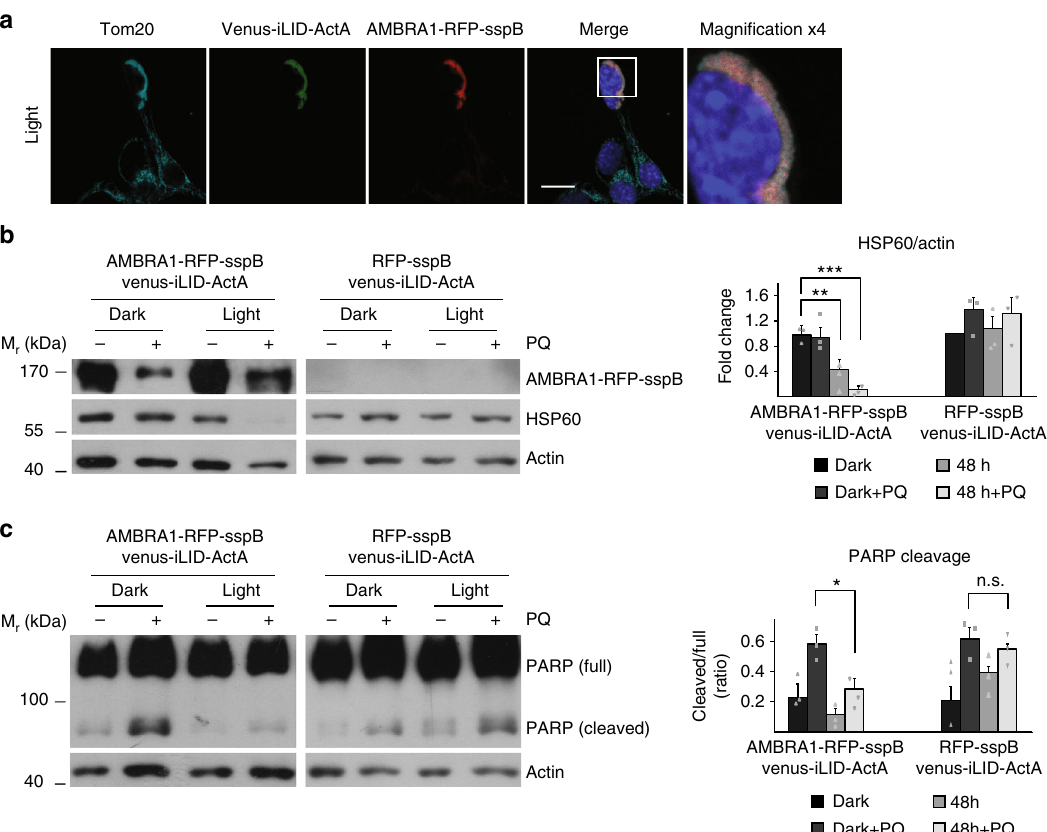
Fig. 6 Optogenetic-mediated mitophagy prevents apoptosis in a model of neurotoxicity. a ETNA (Embryonic Telencephalic NAïve) cells co-expressing Venus-iLID-ActA/AMBRA1-RFP-sspB were irradiated with pulsed (1 s light + 1 min dark) light for 4 h, then fi xed and stained for nuclei (DAPI, blue) AMBRA1 (red) and Tom20 (cyan). Inset: ×4 magni fi cation. Scale bar: 10 μ m. b ETNA cells, transfected with Venus-iLID-ActA/AMBRA1-RFP-sspB or Venus-iLID-ActA/RFP-sspB (negative control), were irradiated with pulsed blue light (1 s light + 1 min dark) for 48 h or left in the dark upon treatment with 250 μ M PQ. Cell lysates were prepared and HSP60 levels (mitochondrial marker) explored in three independent experiments. Actin was used as a loading control. The graph reports the means of the normalized densitometric ratio between HSP60 and actin. Data shown: mean ± S.E.M. Hypothesis